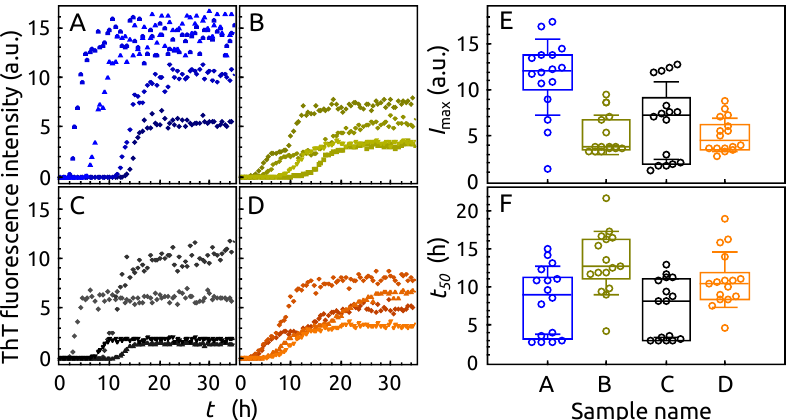
Figure 5. ( A – D ) The aggregation kinetic curves (4 selected of each sample, which represent stochastic process of 16 repeats) of α -syn (not labeled). ( E ) The largest value of ThT fluorescence intensity ( I max ) and ( F ) t 50 values of samples A – D . The interquartile region (shown by the box), standard deviation (whiskers) and a median (horizontal line inside the box) were calculated from 16 curves of each sample. The protein samples: ( A ) α -syn, ( B ) α -syn with S100A9, ( C ) α -syn with CaCl 2 , ( D ) α -syn with S100A9 and CaCl 2 . Protein solution 100µM α -syn, 0µM or 100µM S100A9, 25mM HEPES, 100mM NaCl, 0.02% sodium azide, 50µM ThT, 1mM DTT, 0mM or 1mM CaCl 2 , pH 7.4. Aggregation at 37 ◦ C,